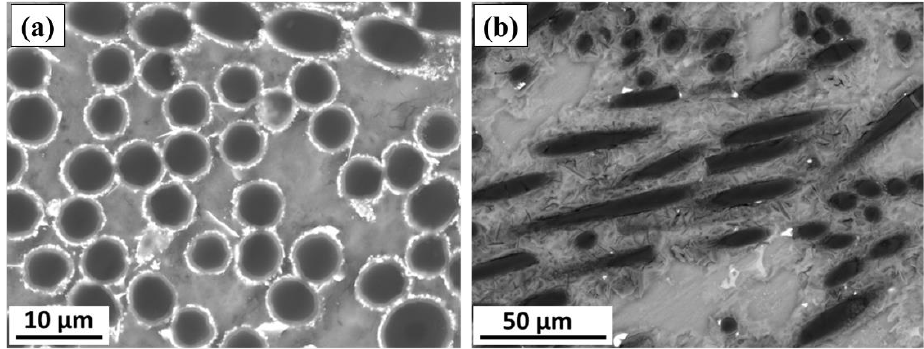
Figure 7. SEM images showing the microstructure of the AZ91/23 vol.% carbon fiber composite specimens machined; ( a ) parallel and ( b ) normal to the reinforced plane.